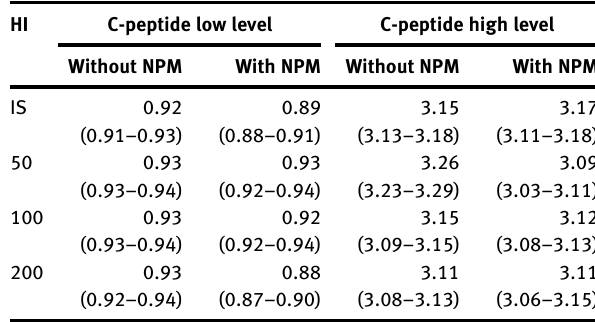
Table  : High and low concentration of C-peptide (ng/mL) median values (min – max).